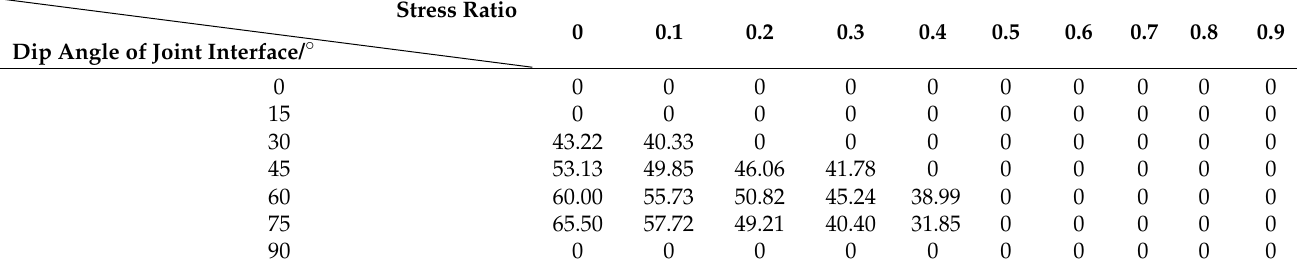
Table 3. Interfacial crack initiation angles when K IC , j / K IC , r = 0.8 ( ◦ ).